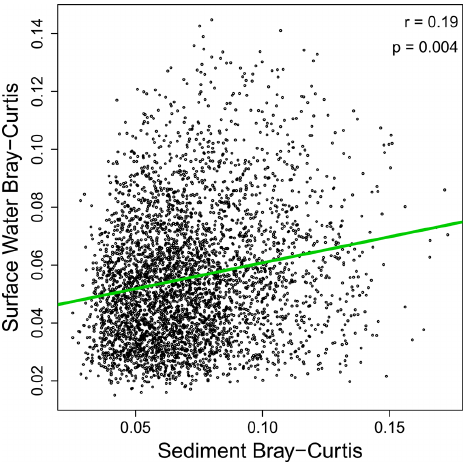
Figure 4. Transformation profiles of OM in sediments and surface water were weakly related to each other. Bray–Curtis dissimilari- ties in surface water and sediments are plotted against each other, with their relationship evaluated via the Mantel test to control for non-independence among data points (see “Methods” section). The Pearson correlation coefficient and the Mantel-based p value are provided in the panel. While significant, the relationship is ex- tremely weak, suggesting lack of a meaningful relationship. One outlier sample was discovered and excluded from this analysis. Fig- ure S1 includes the outlier, which does not change the interpreta- tion; it only makes it harder to see the data.